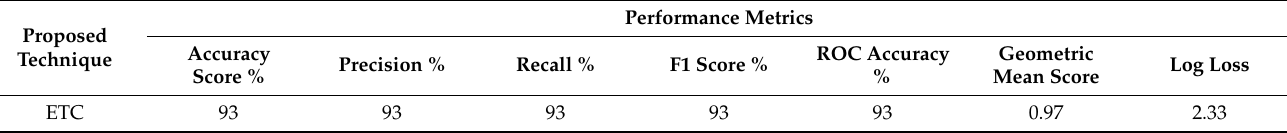
Table 6. The proposed ETC approach performance metrics results in evaluations.